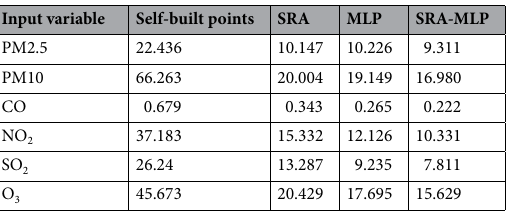
Table 5. RMSE of six types of air pollutant concentrations between self-built points, model forecast values and national control point.